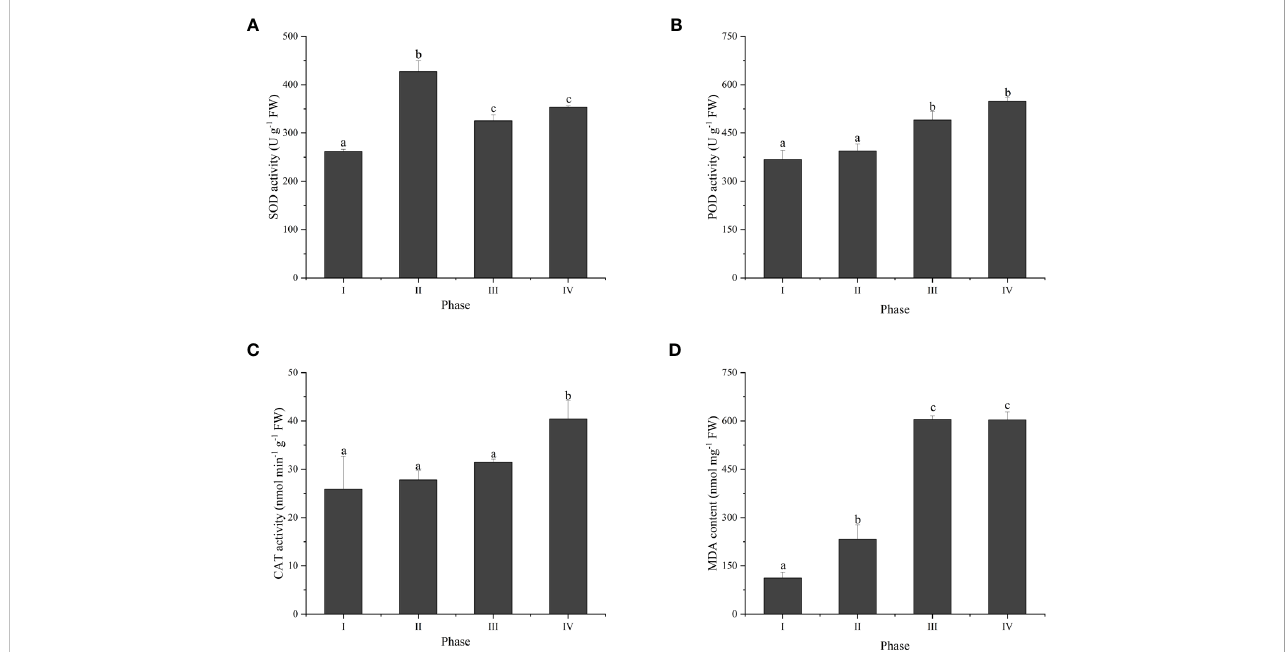
FIGURE 3 The antioxidantactivity andMDAcontentindifferentphasesof tetrasporeformationin G.lemaneiformis. (A) Superoxidedismutase (SOD)activities; (B) Peroxidase (POD)activities; (C) Catalase (CAT)activities;and (D) MDAcontent.Datapresentedare themeans±SDsfromthreeindependentexperiments, anddifferentletters indicate asigni fi cantdifference (p<